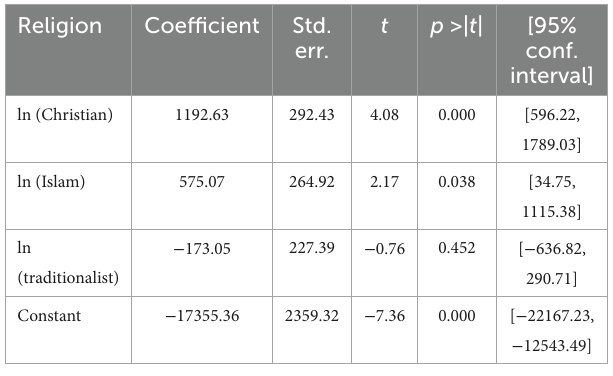
TABLE 3 Regressing COVID on ln